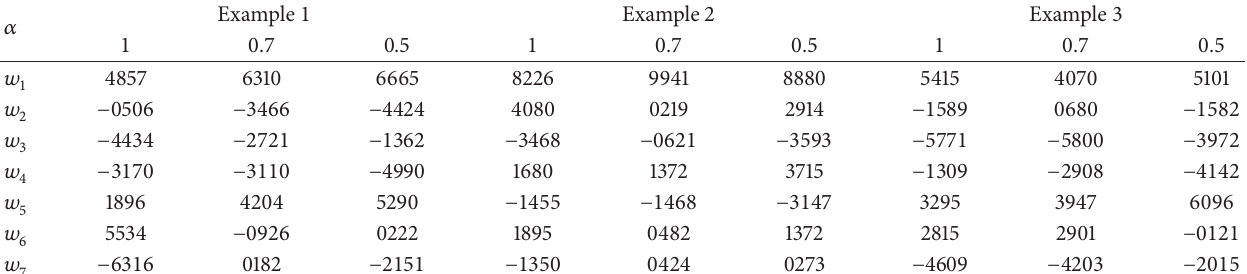
Table 1: Weights ( ×10 −4 ) obtained along with the solution of Examples 1, 2 , and 3 .